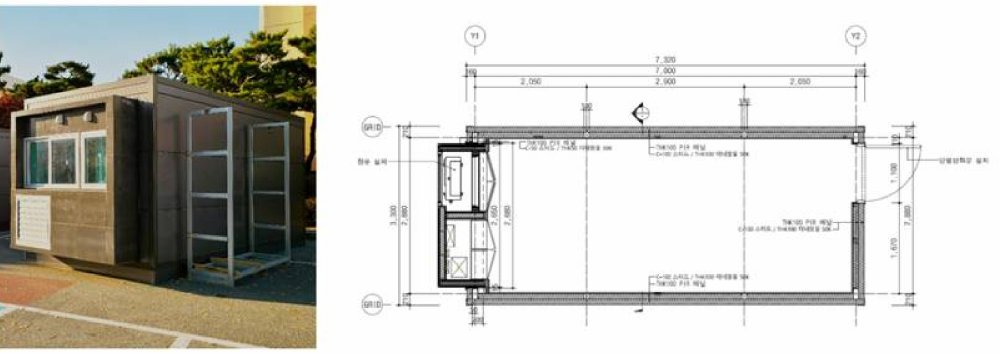
Figure 1. Side view and floor plan of the test